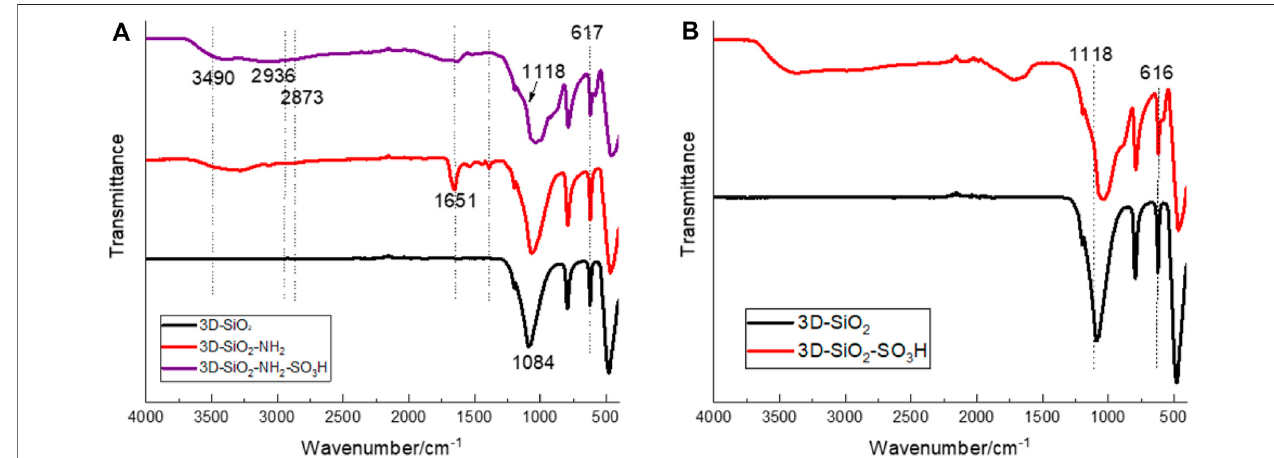
FIGURE 3 | (A) FTIR of 3D SiO 2 -NH-SO 3 H and (B) 3D SiO 2 -SO 3